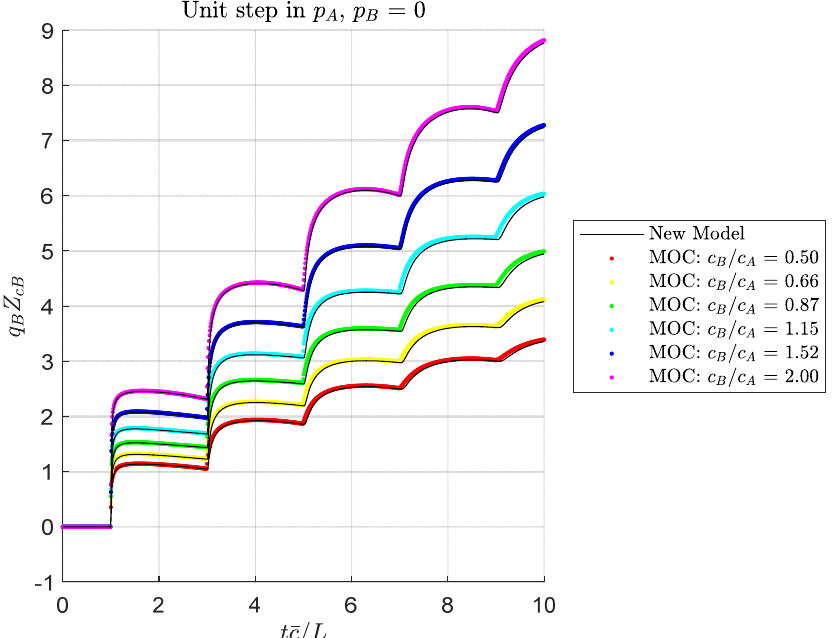
Figure 4. Outlet flow response to a unit step in inlet pressure, for an open exit, showing effect of taper ratio.